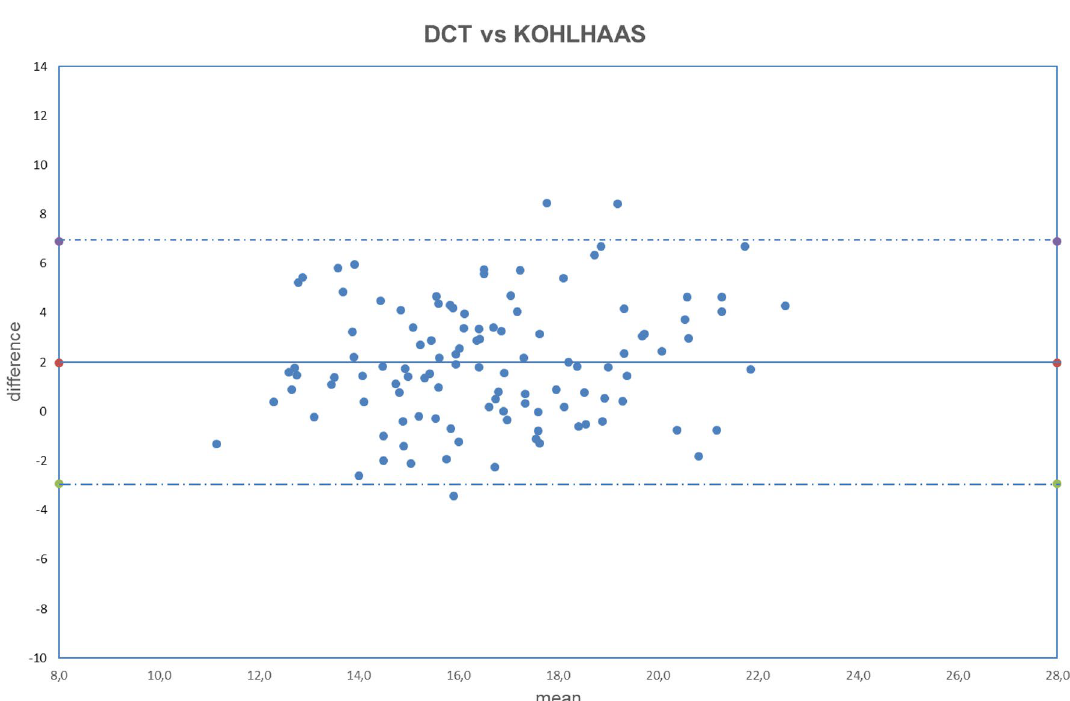
Figure 8. Bland–Altman plot between IOP measured with DCT and GAT corrected with Kohlhaas formula. Dashed line: mean difference. Dash-dotted lines: mean difference (1.98 mmHg) ± 2 standard deviation (2.46 mmHg) of the